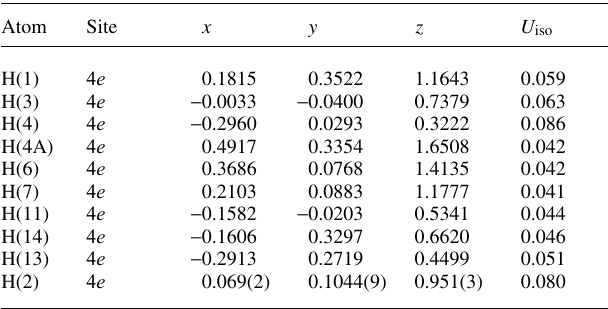
Table 2. Atomic coordinates and displacement parameters (in Å 2 )